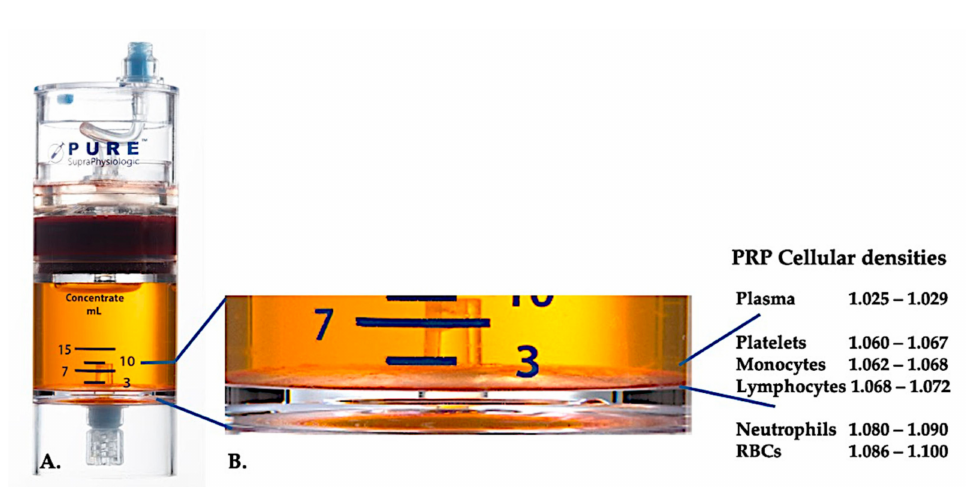
Figure 1. Cellular density separation of whole blood following a two-spin centrifugation procedure using the PurePRP-SP ® device (EmCyte Corporation, Fort Myers, FL, USA). After the first centrifugation procedure, the whole blood components are separated in two basic layers, the platelet (poor) plasma suspension and the RBC layer. In A, the second centrifugation step has been completed. The factual needed PRP volume can be extracted for patient application. The magnification in B shows at the bottom of the device the organized multicomponent bu ff y coat layer (indicated by the blue lines), containing high concentrations of platelets, monocytes, lymphocytes, based on density gradients. In this example, a minimal percentage of neutrophils ( < 0.3%) and RBCs ( < 0.1%) will be extracted, following a neutrophil poor C-PRP preparation